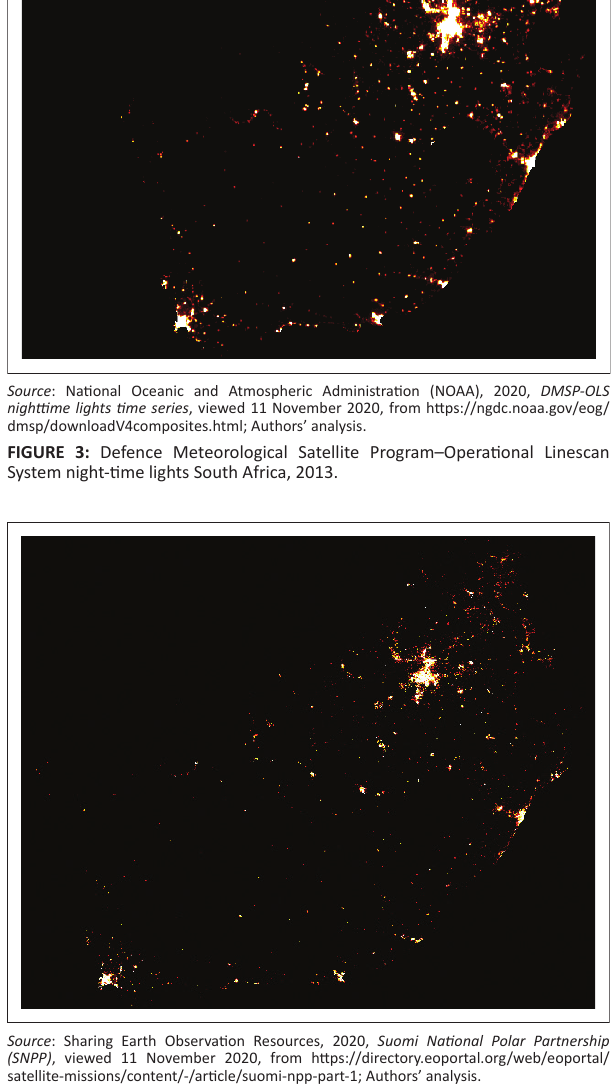
FIGURE 4: Suomi National Polar Partnership–Visible Infrared Imaging Radiometer Suite night-time lights South Africa, 2013.